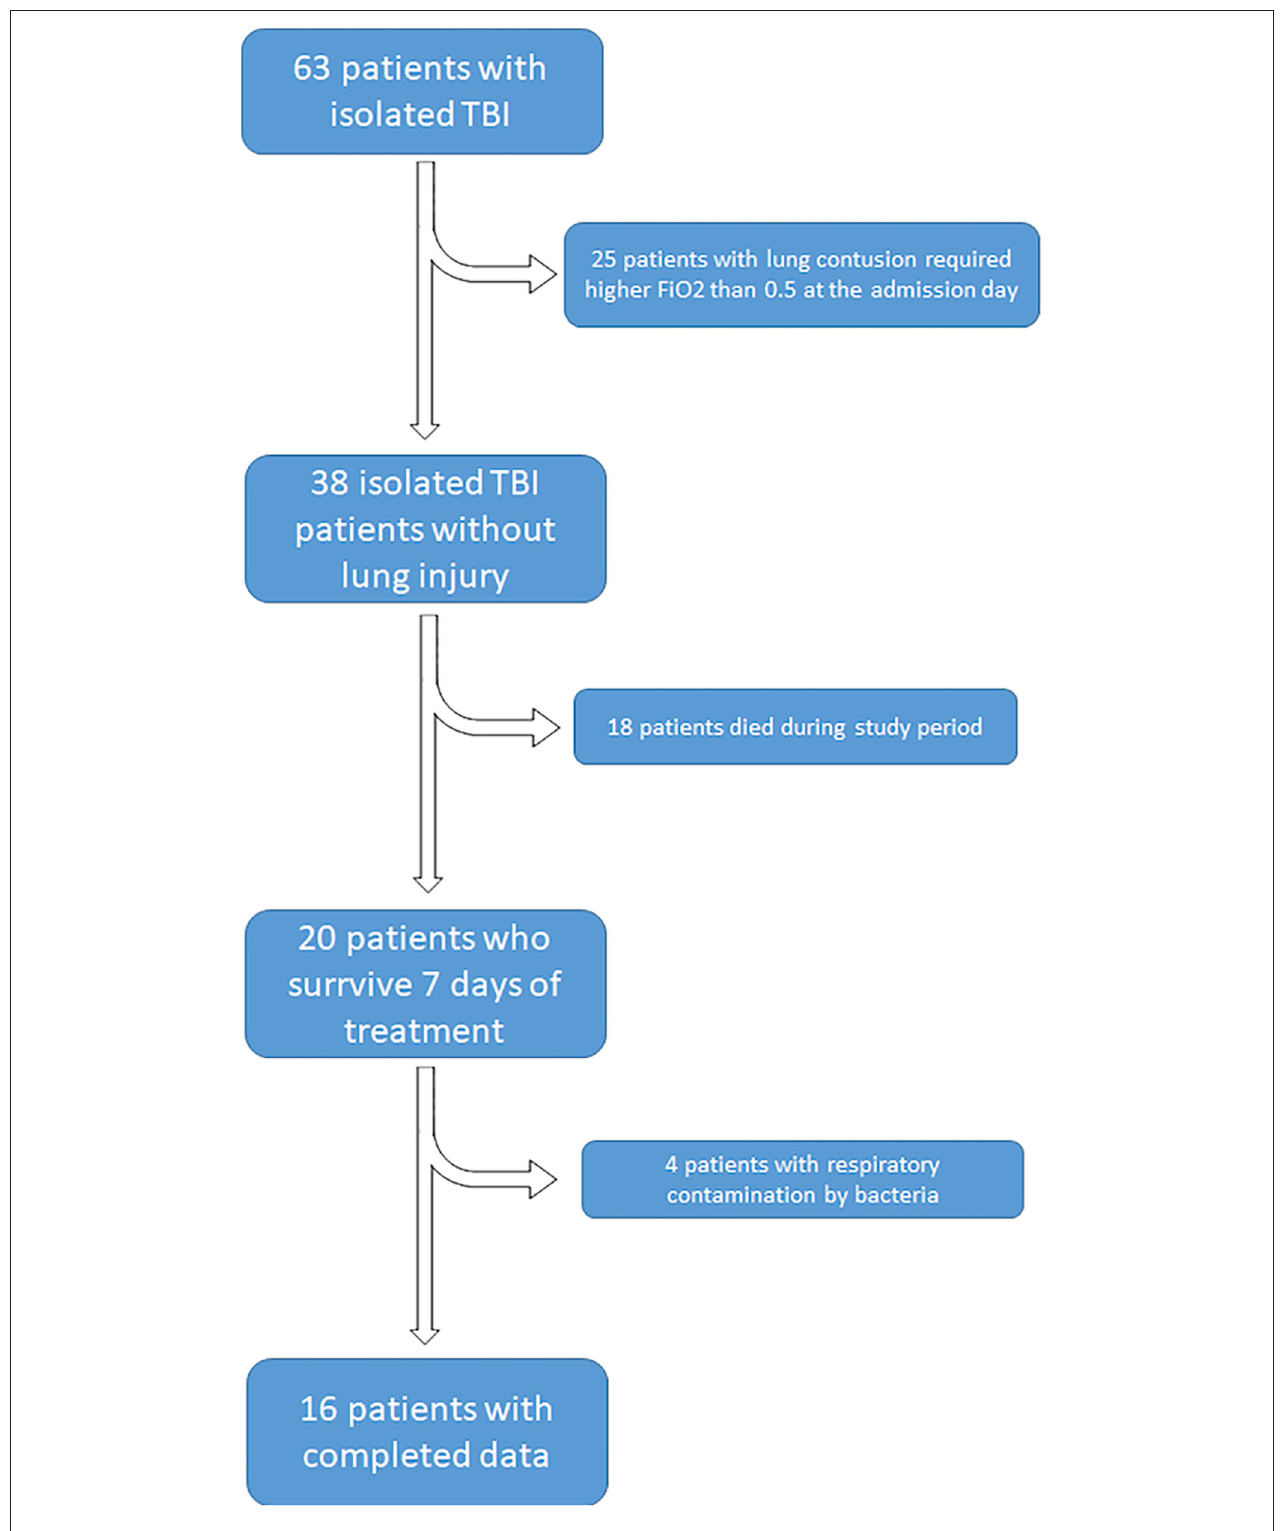
FIGURE 1 | Demographic and clinical characteristics of the studied population.